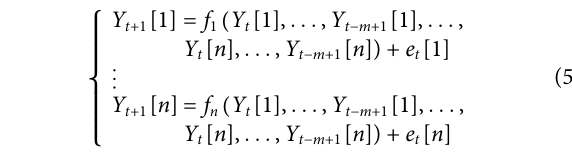
Frontiers in Big Data |